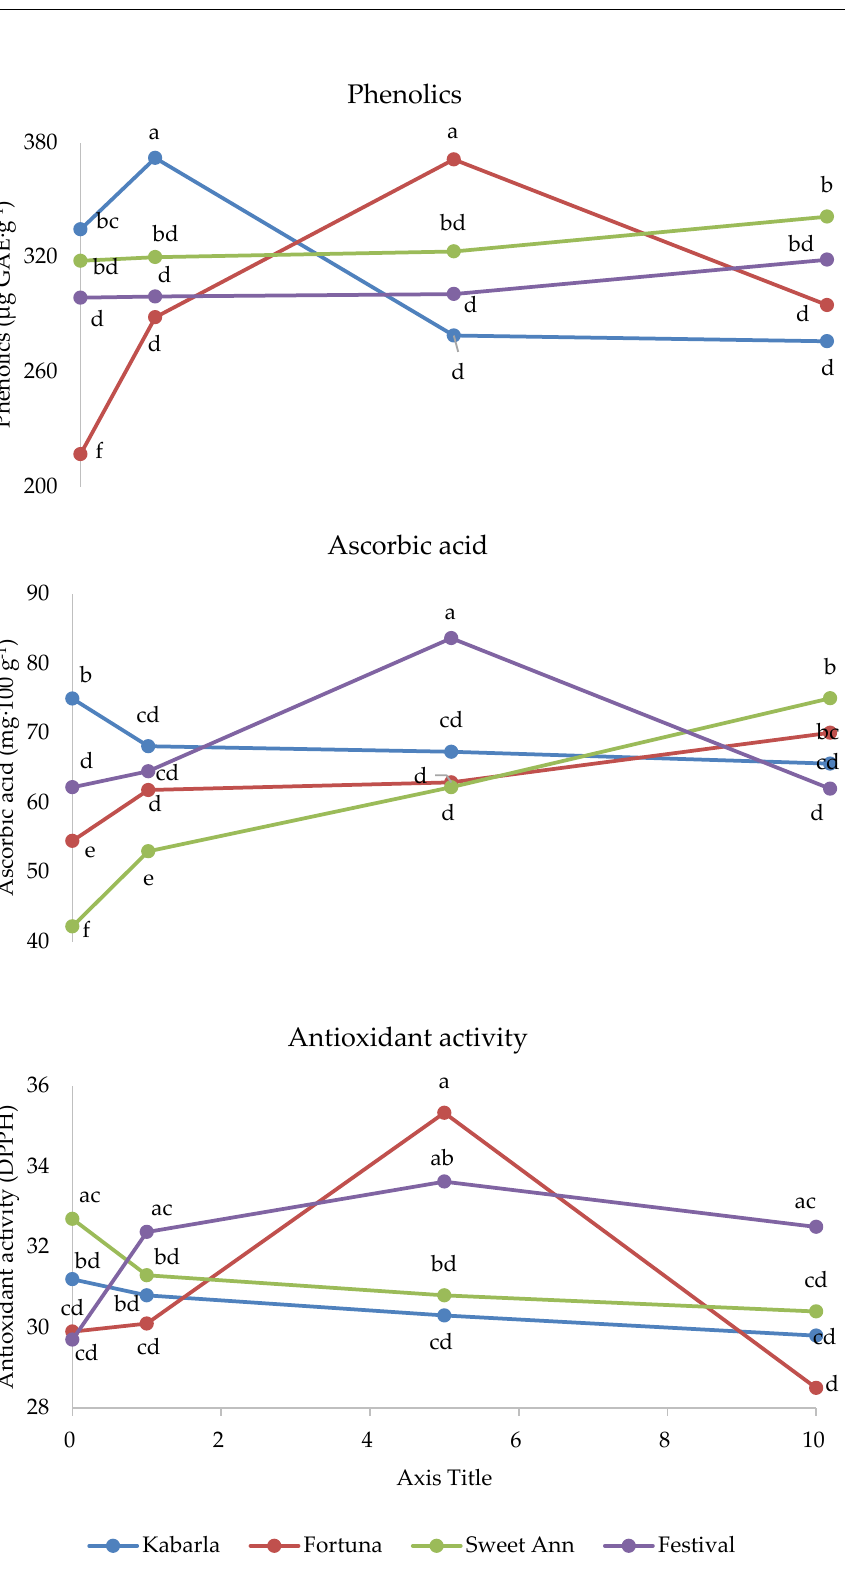
Figure 5. Interaction between Cultivar and Melatonin dose on phenolics and ascorbic acid content, and on antioxidant activity of strawberry fruits grown in Isparta region (Turkey), the values followed by different letters are statistically different according to Tukey’s HSD test at p ≤